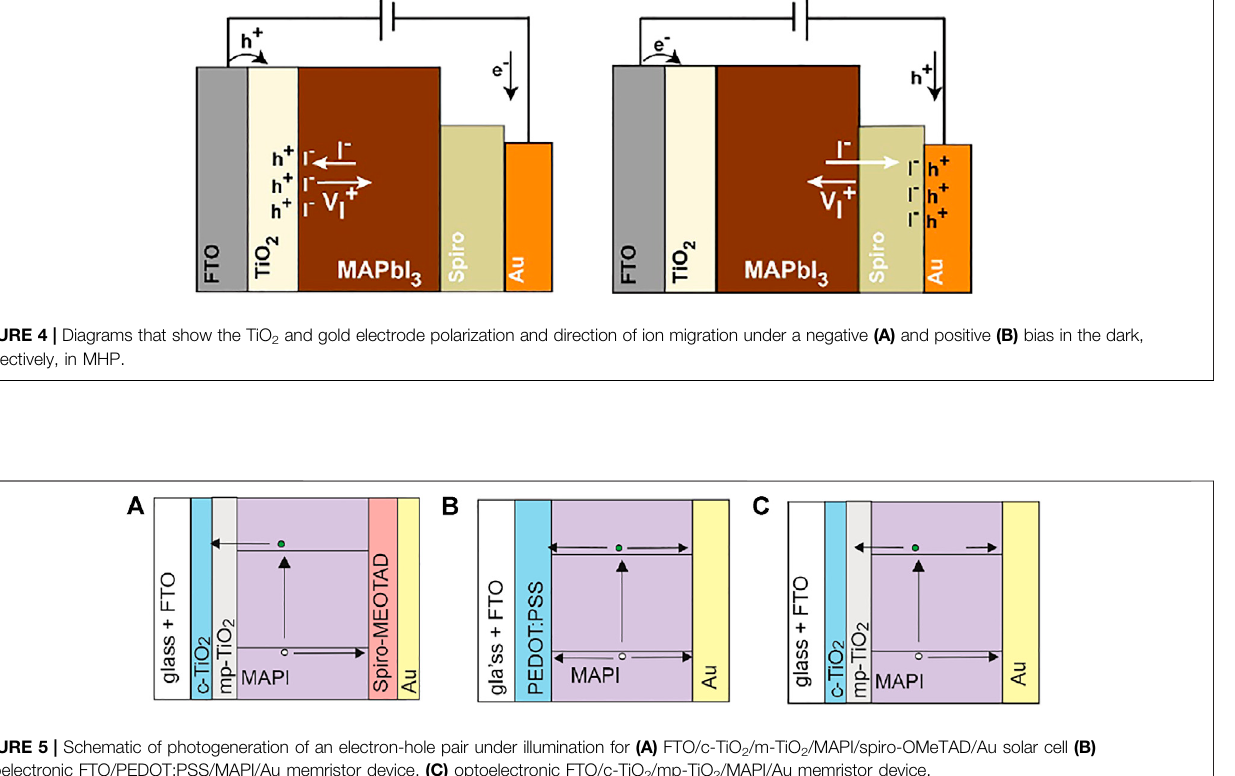
(B) 2 /m-TiO 2 /MAPI/spiro-OMeTAD/Au solar cell